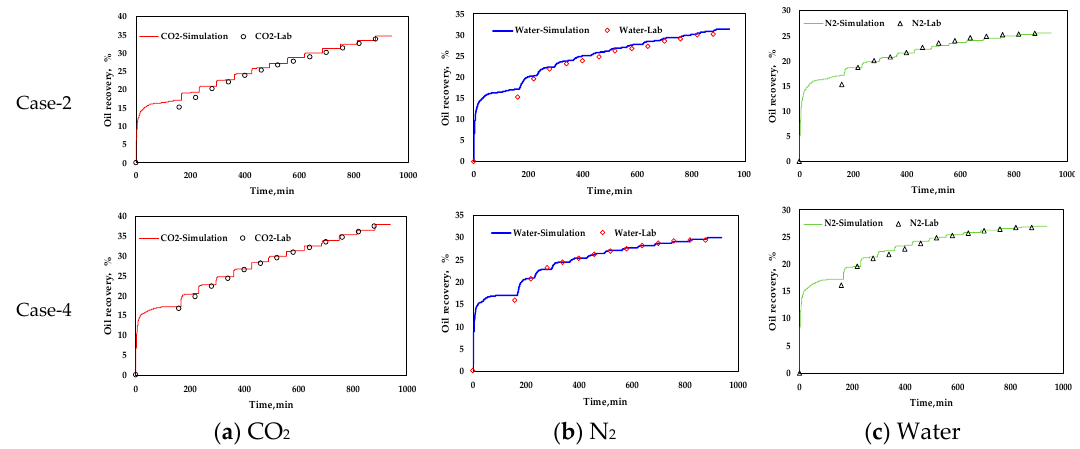
Figure 3. Flowchart of the huff-‘n-puff experiments. In a specific experimental process, first, we wash, dry and weigh the tight core. The core is saturated with a vacuum saturate. The weight of the core before and after oil saturation is measured separately to determine the weight of oil. Finally, 3.5 mL oil is saturated in the tight core. Then, the core is placed into the core holder. A confining pressure of 30 MPa was applied to the core holder by the hand pump. Then it was saturated with an extra 1.2 mL of oil when initial pressure reached 30 MPa. The viscosity of the oil is 6 mPa·s at 60 °C. The entire system was placed in an incubator at 60 °C. Thus, the core scale tight reservoir system has been simulated using a lab method. The injection scheme for the huff-‘n-puff process is as follows: first, reduce the core pressure from an initial pressure of 30 MPa to 5 MPa. Then, inject CO 2 /N 2 /Water until the BHP reaches 40 MPa. The huff-‘n-puff is repeated 12 times. The oil produced in the depletion process and CO 2 /N 2 huff-‘n-puff processes can be directly weighed, while in water huff-‘n-puff, the water should be dried before weighing the produced oil. The lab method can only provide practical oil recovery data. Subjected to laboratory